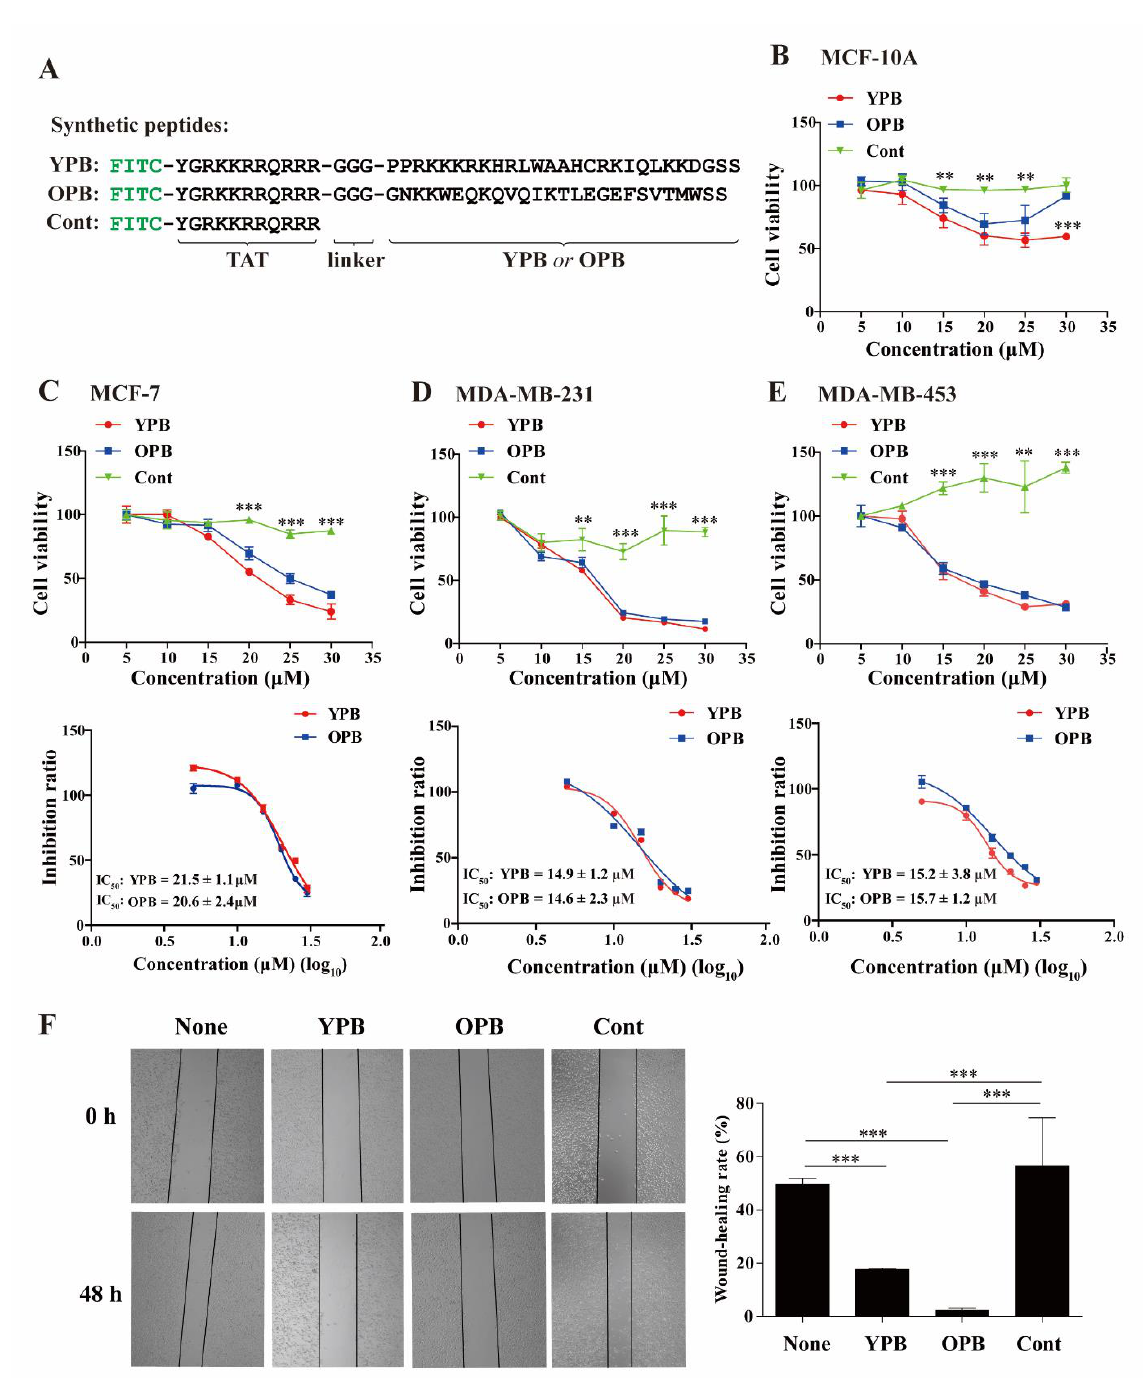
Figure 2. YPB and OPB peptides reduced breast cancer cell viability and disrupted YY1-EZH2 interaction . ( A ) The design and sequences of the synthetic YPB, OPB, and Cont peptides. FITC: fluorescein isothiocyanate; TAT: a cell-penetrating peptide derived from human immunodeficiency virus. ( B – E ) Inhibitory effects the YPB and OPB peptides on breast cancer cells. MCF-10A, MCF-7, MDA-MB-231, and MDA-MB-453 cells were individually treated with different concentrations of YPB, OPB, and Cont peptides for 48 h, followed by WST-1 assays to determine cell proliferation. Then, cell viability (upper panels) and peptide inhibition ratios (lower panels) were calculated, with the IC 50 values in these cell lines embedded in the graphs. ( F ) Scratch assay to test the effects of PBS, YPB, OPB, and Cont peptides on cell migration. Scratches on the plates with overnight cultured MDA-MB-231 cells were created with immediate addition of PBS, 30 µ M of YPB, OPB, and Cont peptides into the medium. The scratches were imaged after 48 h, and the quantitation of cell migration was presented at right. Viability of nontumorigenic MCF-10A cells treated by the 3 peptides. Data represent the mean ± S.D. ** p < 0.01, *** p <